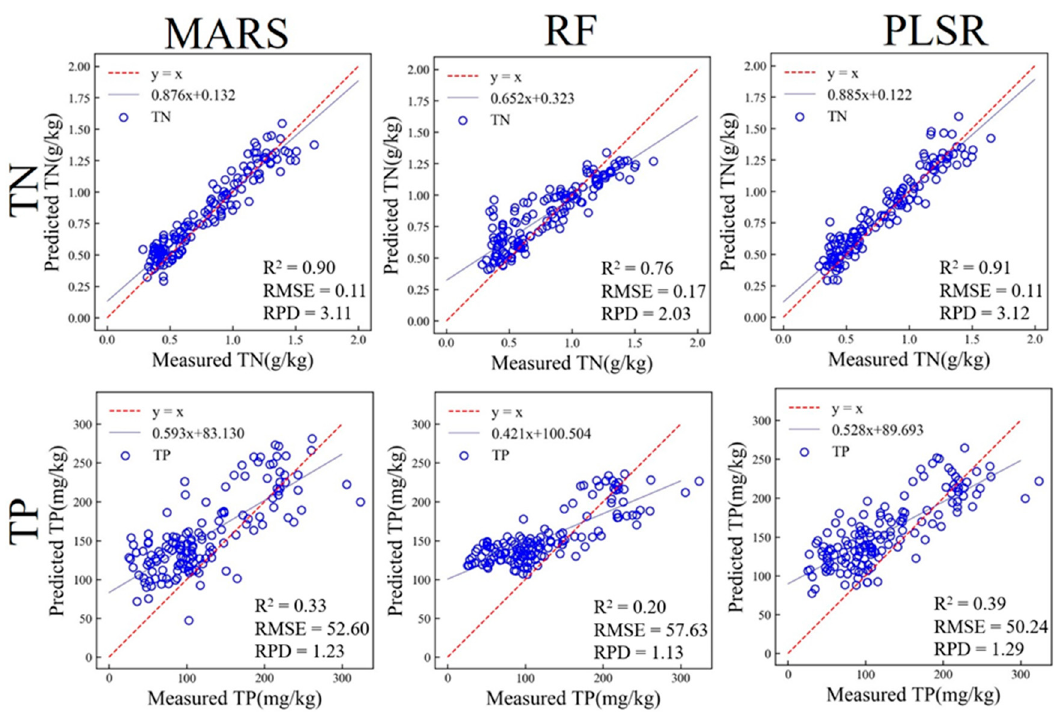
Figure A1. Sca tt er plot of soil TN and TP prediction based on laboratory vis-NIR.